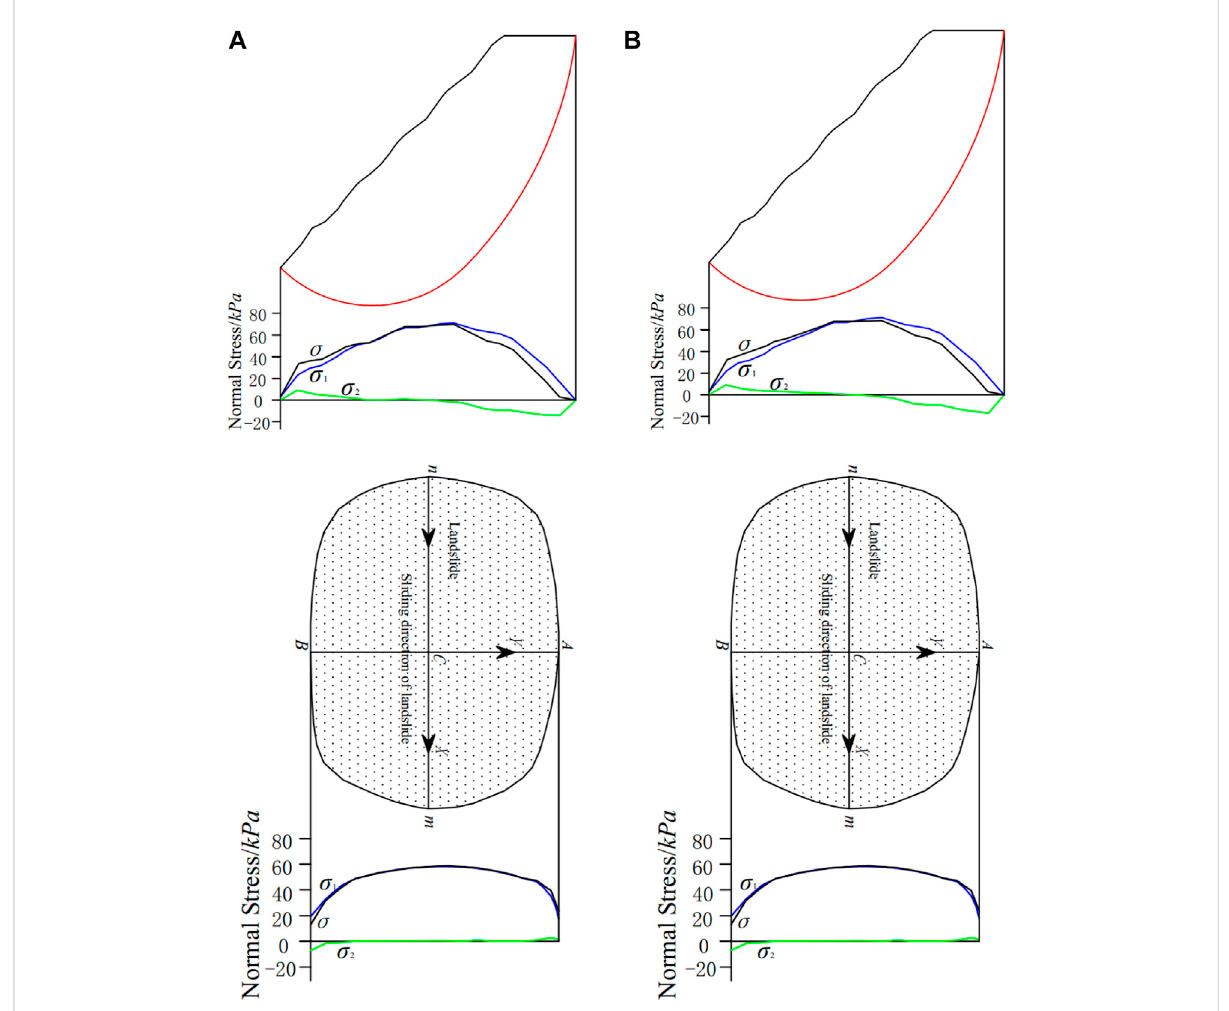
FIGURE 4 Normalstressdistributionsofslipsurfacewithdifferentcalculations. (A) theBishopmethodbasedonGIS(Alongtheslidingdirectionoftheslide body) and (Perpendicular to the direction of the slide body); (B) the Janbu method based on GIS (Along the sliding direction of the slide body) and (Perpendicular to the direction of the slide